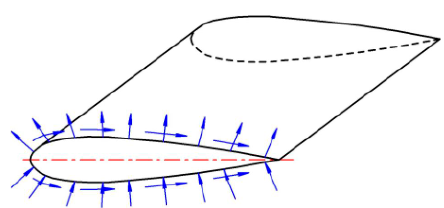
Figure 1. Aerodynamic pressure applied to an aircraft wing.